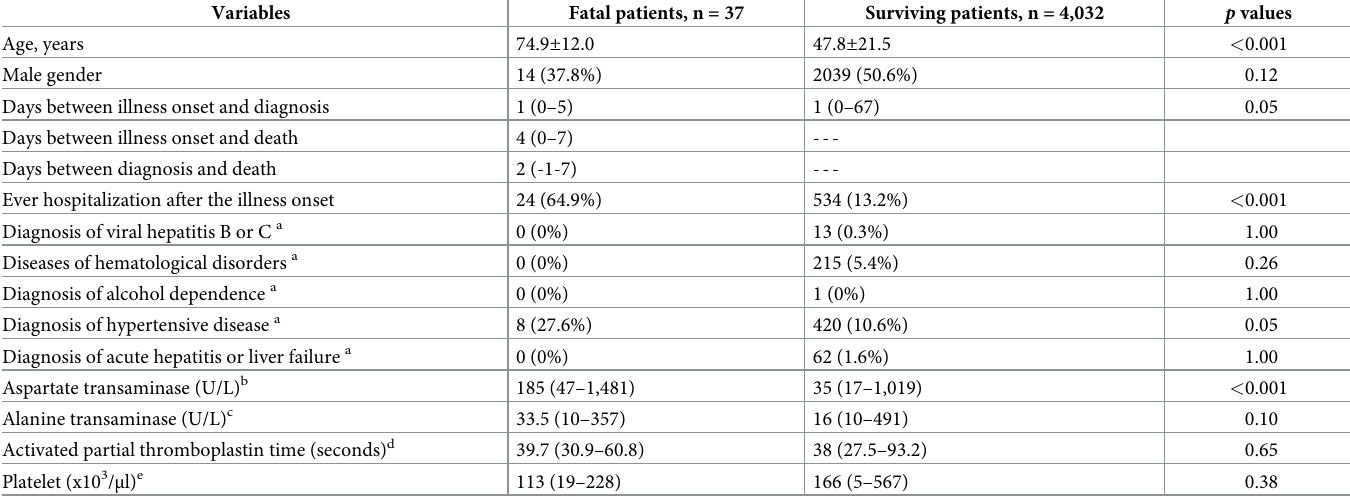
Table 1. Characteristics and initial laboratory data at the onset day of dengue fever (D0) among 4,069 patients. Variables Fatal patients, n = 37 Surviving patients, n =